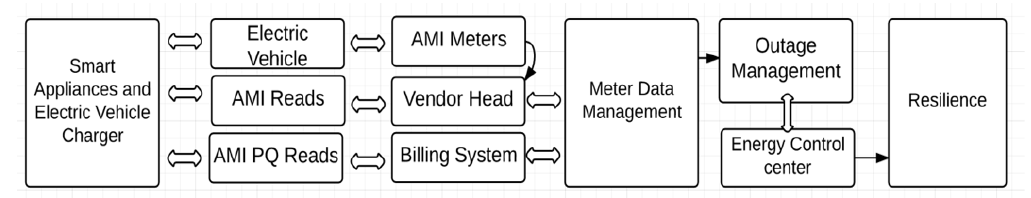
Figure 4. Smart grid architecture: test network. (PQ in Figure refers to Power Quality).